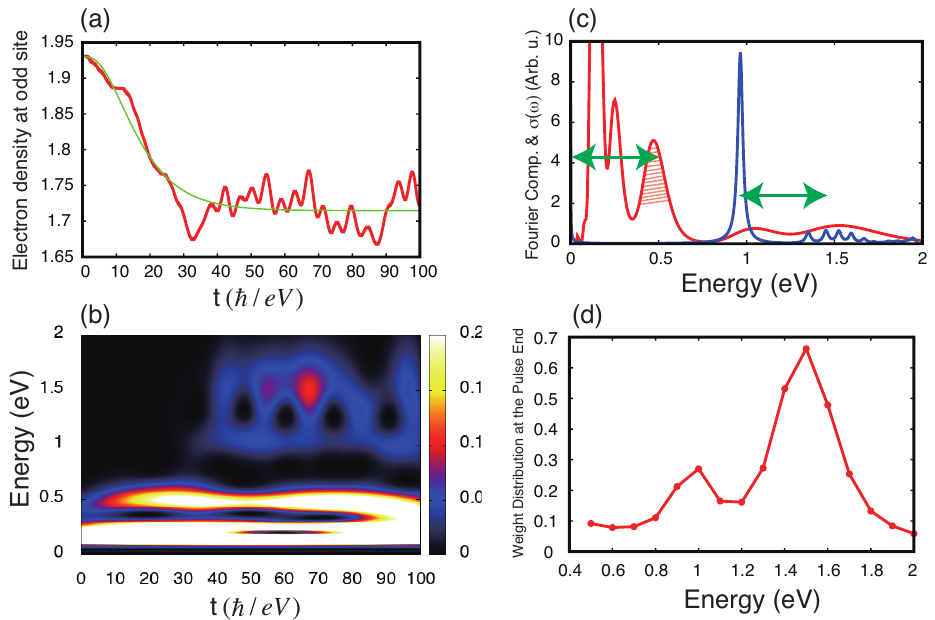
Figure 4. ( a – c ) Same as Figure 3, but for ∆ ef f = 0.50 eV and ¯ h ω c = 1.5 eV; ( d ) weight distribution at the pulse end, i.e., t = τ d